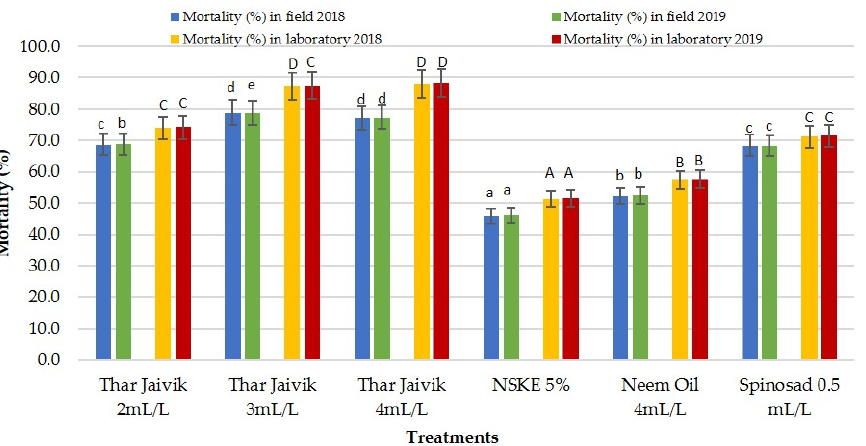
Figure 4. Efficacy of different concentrations of “Thar Jaivik 41 EC” and other biopesticides against H. armigera on cucurbits during 2018 and 2019 (mortality (%) mean of 1 and 3 days after application). NSKE: neem seed kernel extract. Different lowercase letters and uppercase letters indicate significant differences in treatments within field and laboratory conditions, respectively.